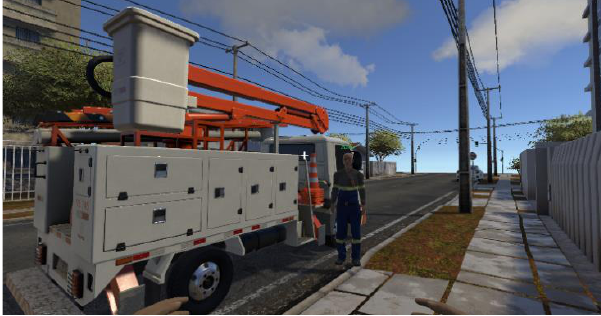
Figure 8. An electrician and the truck with elevator bucket.